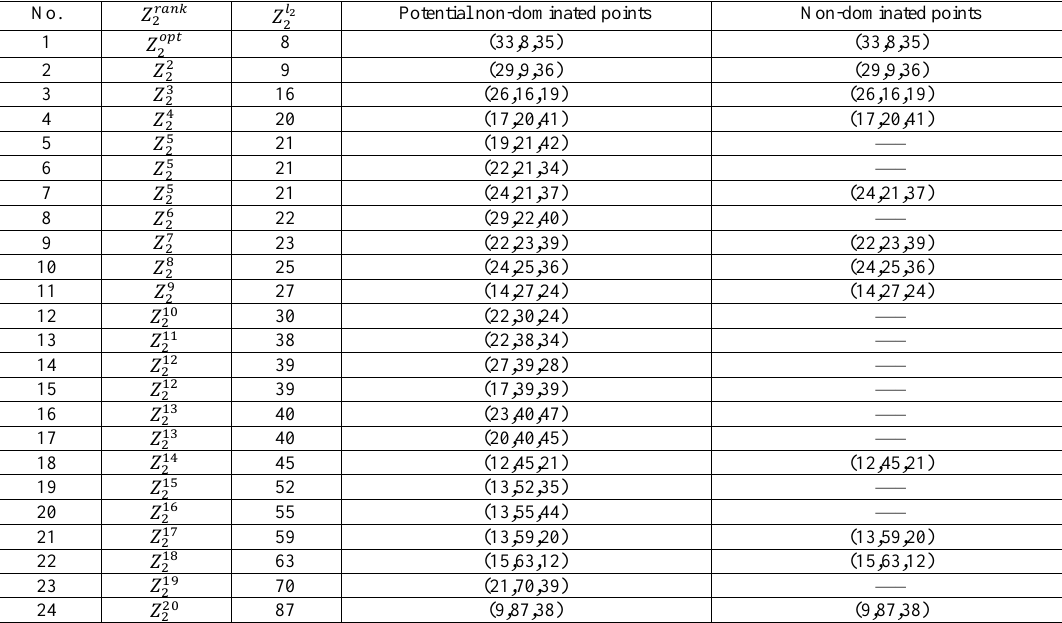
Table 9. Potential non-dominated points for second objective function